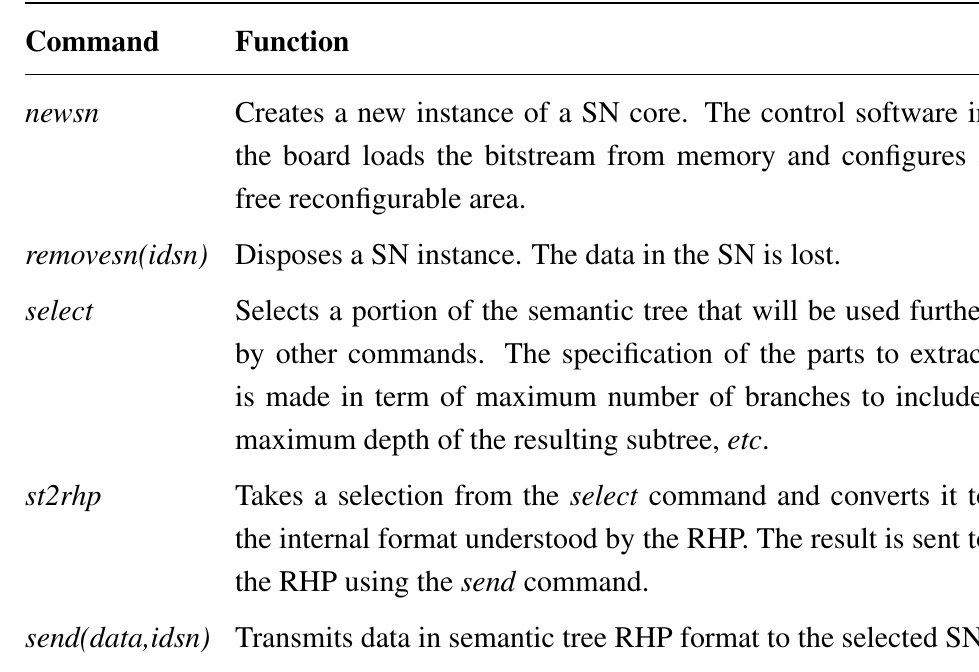
New commands added to Scone to integrate with the proposed Reasoning Hardware